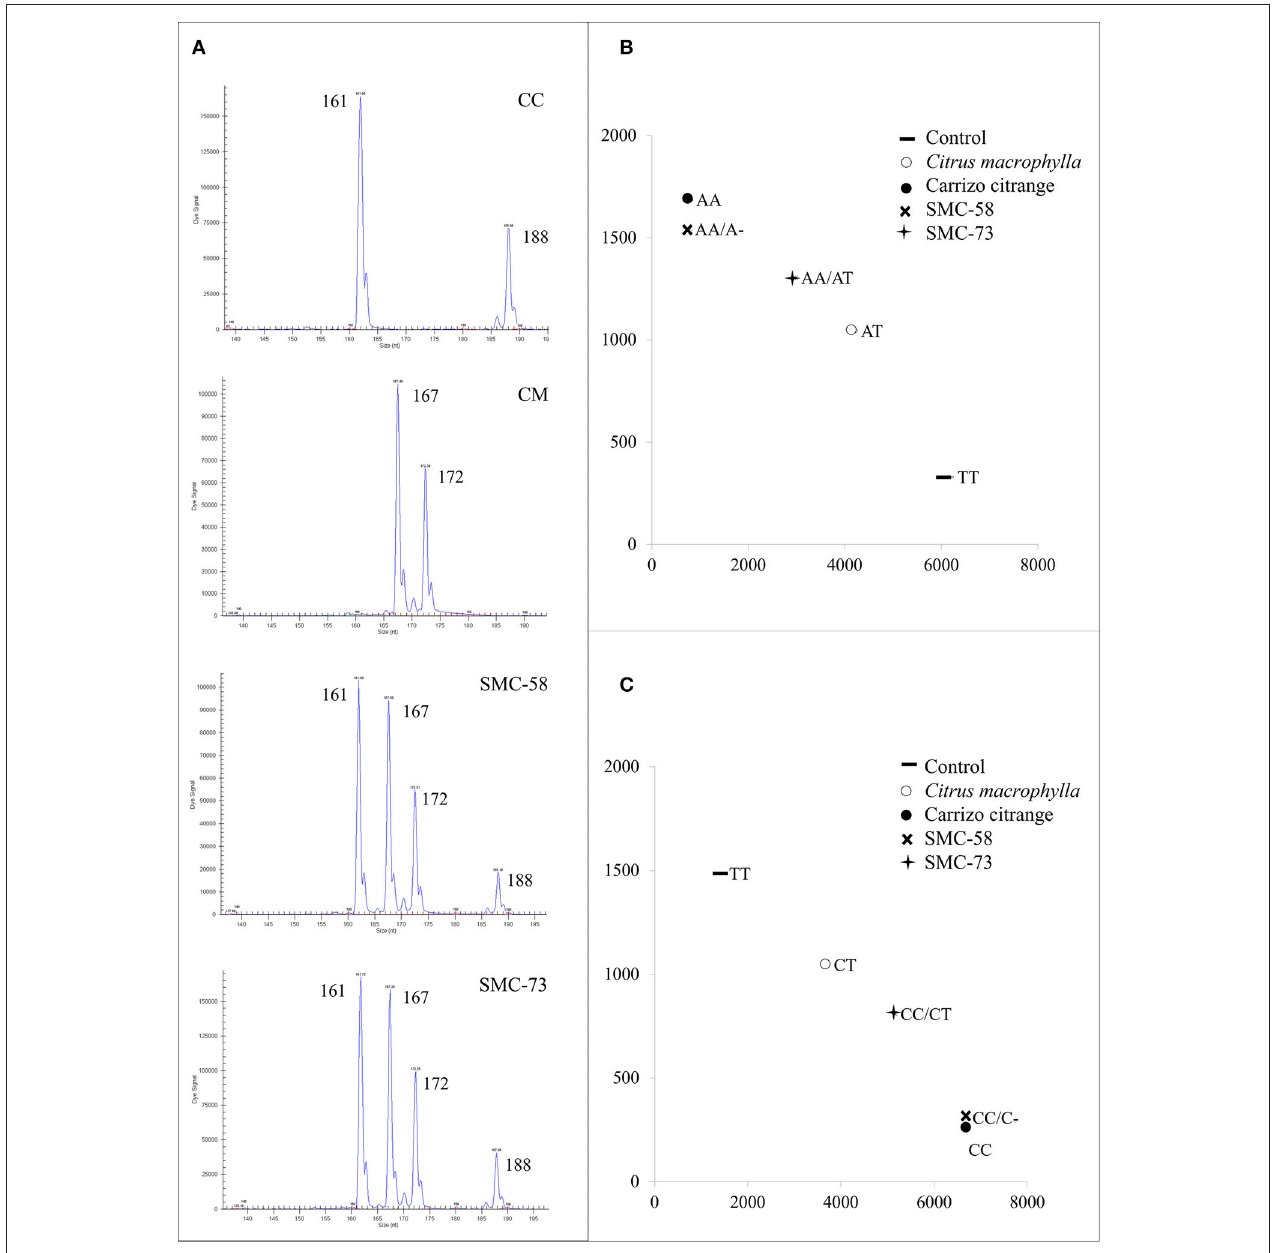
FIGURE 3 | Allelic configurations of the somatic hybrids SMC-58 and SMC-73 and their parents C. macrophylla (CM) and Carrizo citrange (CC). (A) Ci07D06 SSR marker on LG 4 where somatic hybrids display four different alleles from their parents. Numbers indicate the size of the amplified allele in nucleotides (nt). Plot of allele signals of (B) PSY-C461 and (C) AocC593 SNP markers on LG 6. For PSY-C461 SNP marker, CM displayed AT alleles, Carrizo citrange displayed AA alleles, SMC-58 AAA alleles with the loss of T allele from CM and SMC-73 with the alleles of both parents, CM, and CC. For AocC593, CM displayed CT alleles, Carrizo citrange displayed CC alleles, SMC-58 CCC alleles with the loss of T allele from CM and SMC-73 with the alleles of both parents, CM and CC. Letters indicate the allelic configuration for each genotype as: A, adenine; C, cytosine; T, thymine; G,